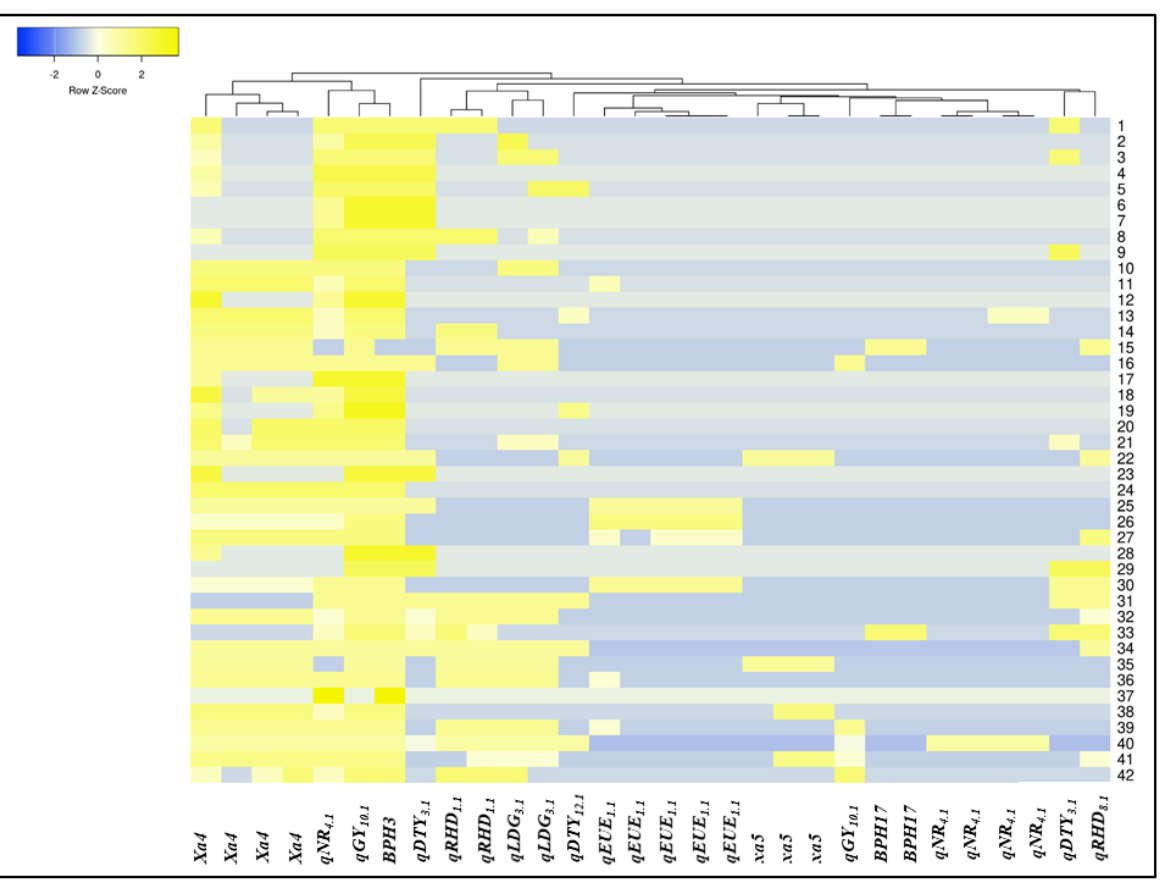
Figure 4. The heatmap indicating the favorable alleles frequency associated with various biotic/abiotic resistance/tolerance traits, seedling establishment, root traits improving the nutrient uptake, grain yield, and yield-related traits in the advanced breeding lines panel. The numerical code represents the breeding panel constituting the advanced breeding lines/donor check/control checks in the breeding panel. The detailed information on the numerical codes has been provided in Table 1. The numerical codes highlighted in the red color indicate the selected promising breeding lines.